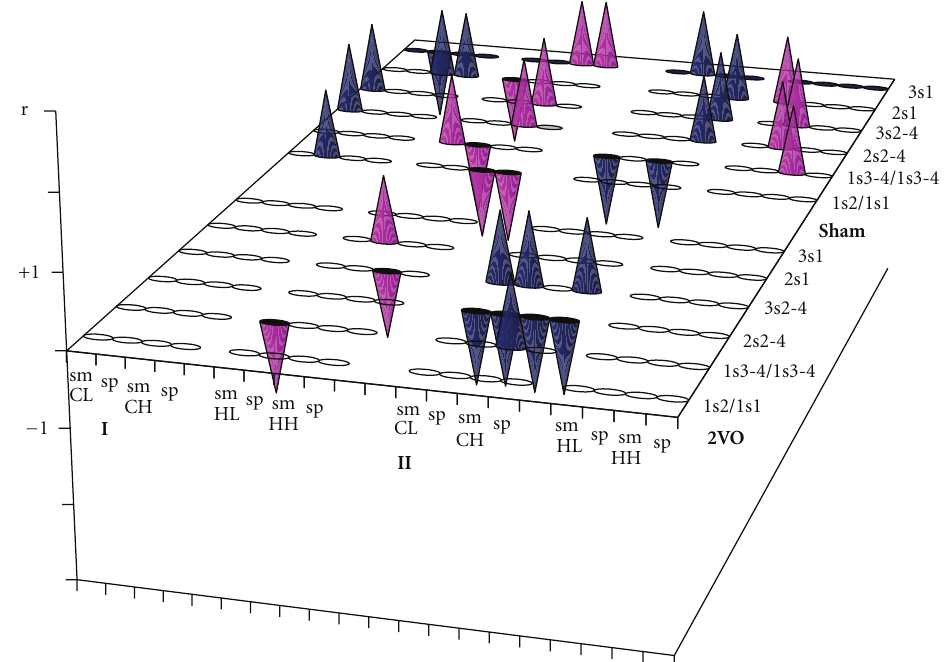
Figure 3: Significant r -criterion values (by the Pearson’s test) of behavioural performance and ChAT activity in rats in the Morris water maze in the spatial contextual (I) and the spatial cued (II) behavioural models under control (sham) and ischaemic (2VO) conditions. 1s2/1s1, 1s3-4/1s2–4, 2s2–4, 3s2–4, 2s1, 3s1 are the same as in Figure 1; sm and Sp, subfractions of the synaptic membranes and the synaptoplasm, respectively, of the cortical light (CL) and heavy synaptosomes (CH) and hippocampal light (HL) and heavy synaptosomes (HH) as in Table 1. In the spatial contextual biochemical subgroup n = 5 for control and 2VO rats; in spatial cued biochemical subgroup n = 4 for control and 2VO